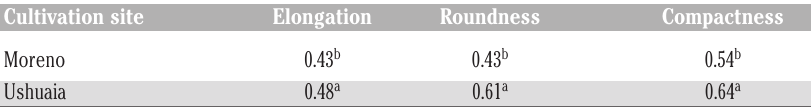
Table 2. Elongation, roundness and compactness indexes of B. microphylla leaf according to the cultivation